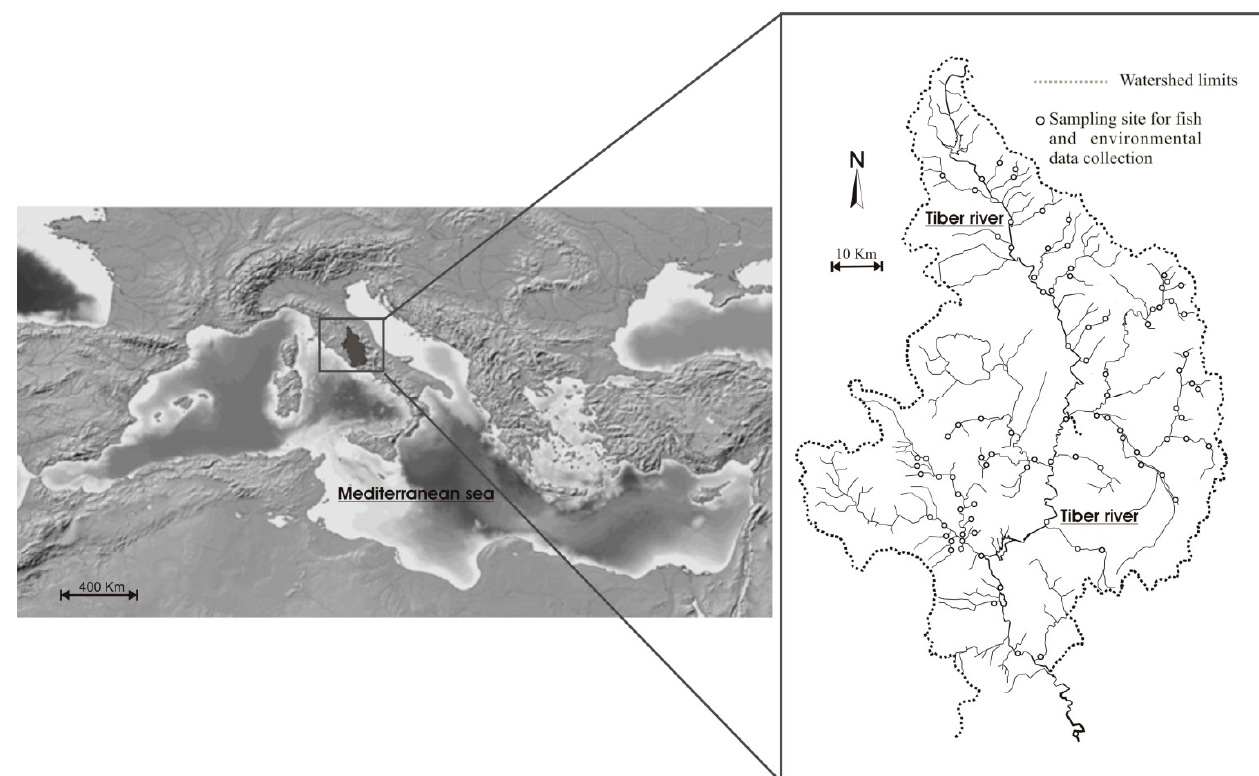
Figure 1. Study area and location of the sampling sites. Mediterranean map adapted from Isac-Cnr 2005.